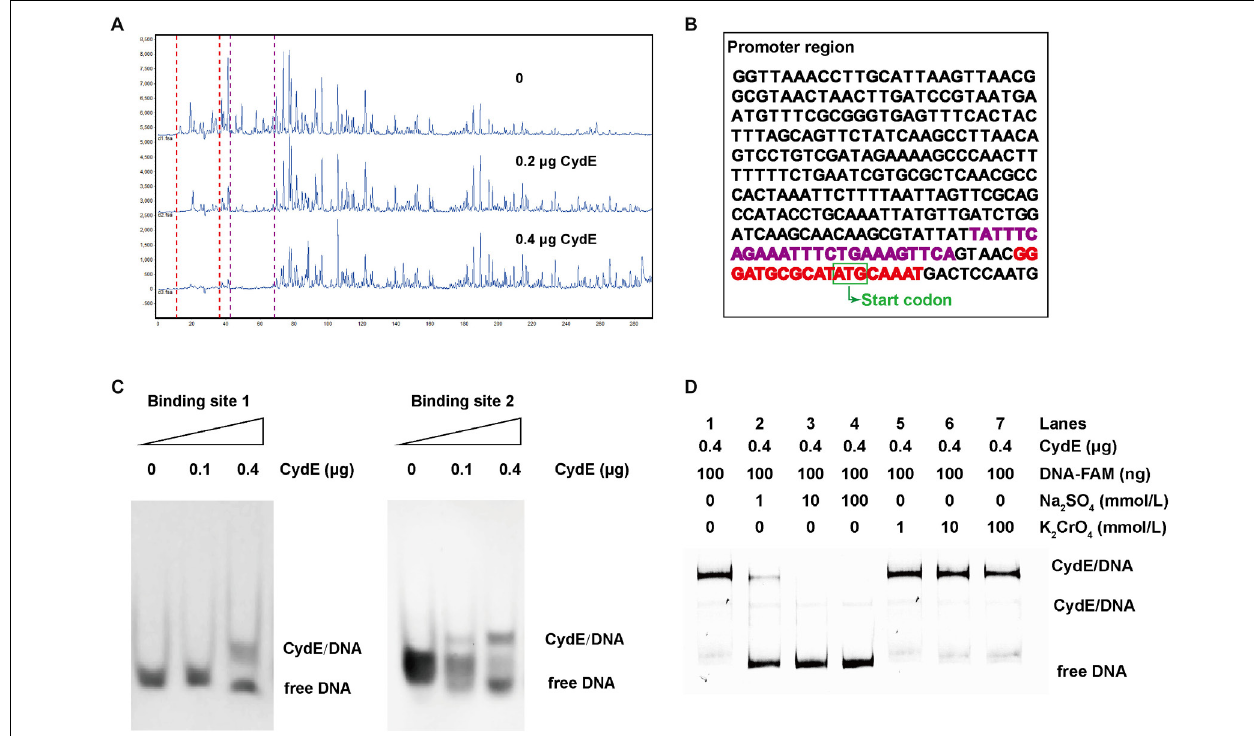
FIGURE 6 | CydE binding sites and derepression analysis. (A) DNA footprinting. FAM-labeled DNA was the same as used in the EMSA and it was incubated with CydE in various amounts. Electropherograms indicated the protection pattern of DNA in different concentrations of CydE. (B) The promoter sequence of cydE . The red and purple highlighted sequences are binding sites 1 and 2, respectively. (C) EMSA for verification of the binding sites of CydE in the promoter region of cydE . The DNA of binding sites 1 and 2 sequences was synthesized and then incubated with CydE protein. The result showed that both the binding sites were shifted after adding CydE. (D) Derepression analysis. The free DNA band is shown with the addition of Na 2 SO 4 , while no similar phenomenon was observed with K 2 CrO 4